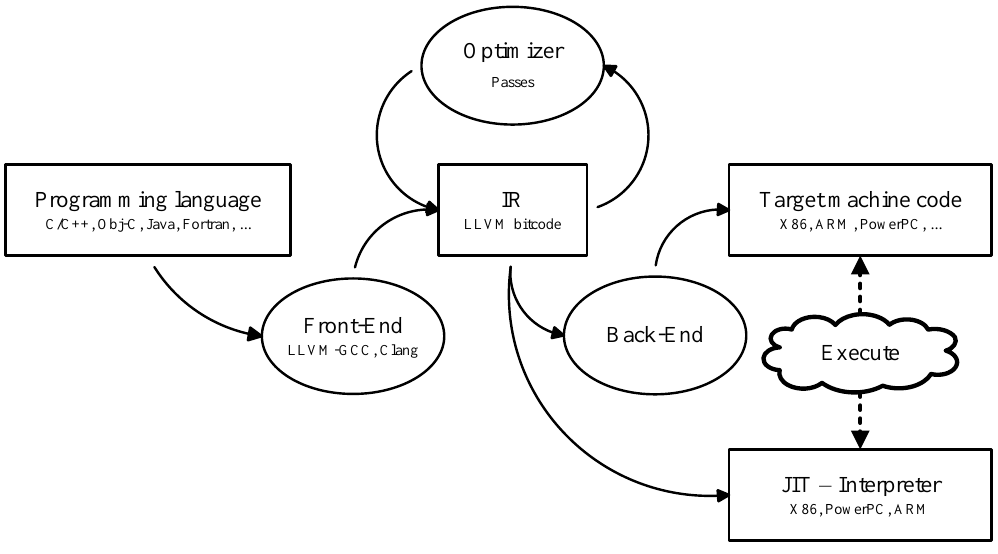
Figure 4. LLVM compilation